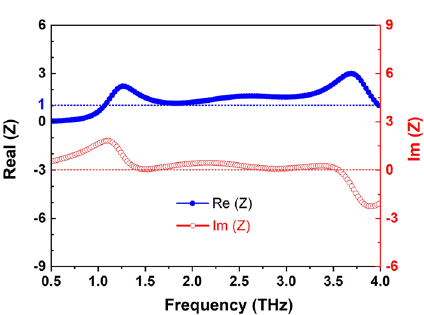
Figure 9. Normalized impedance of the proposed RMS for ABS